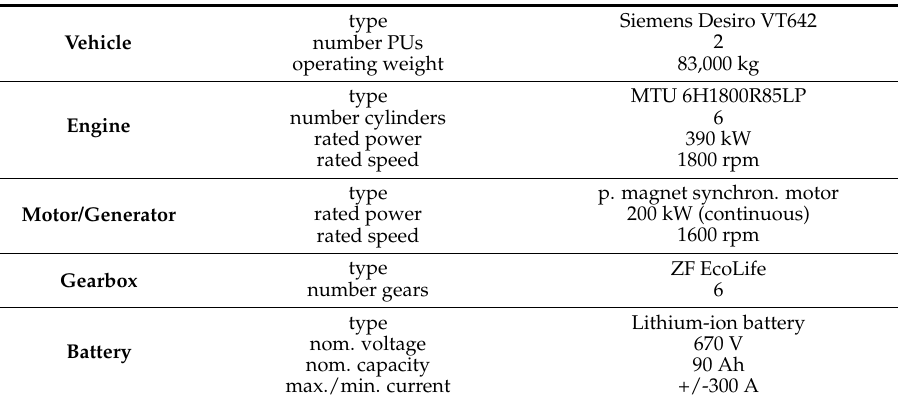
Figure 3. Scheme of a parallel hybrid propulsion system for a diesel multiple unit train (DMU)